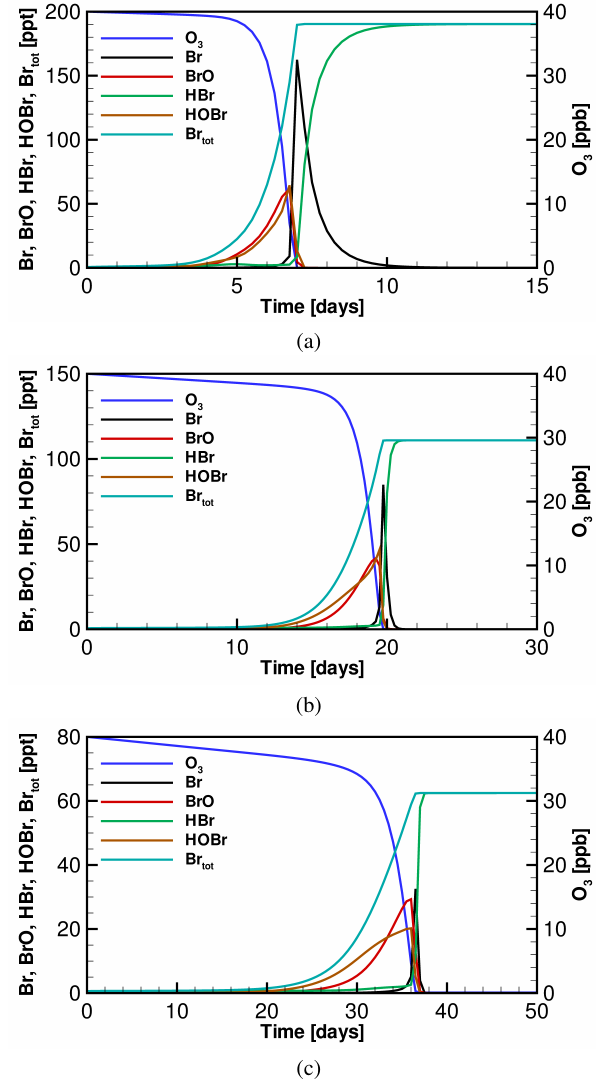
Fig. 1. Time variation of the mixing ratios of ozone and bromine using the bromine-only mechanism for a boundary layer height of (a) 200m, (b) 500m, and (c) 1000m.